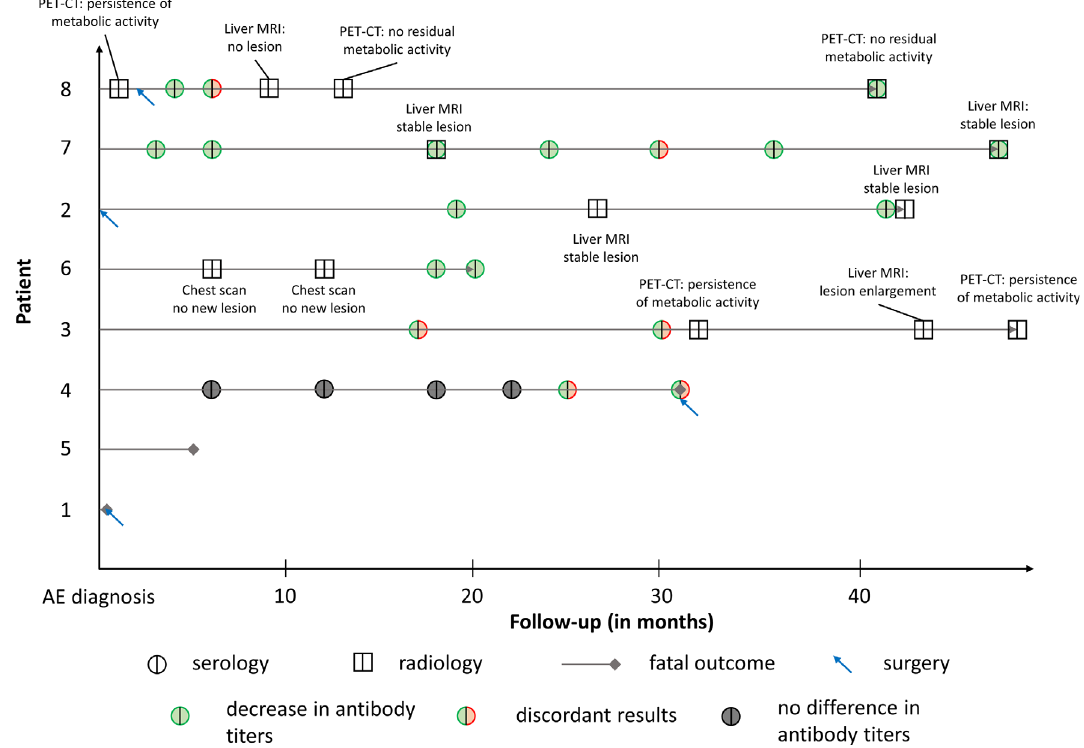
Figure 2. Summary of the patients ’ follow-up after AE diagnosis in solid organ transplant recipients . “ Discordant results ” indicates discordant results in serological assays performed at the same